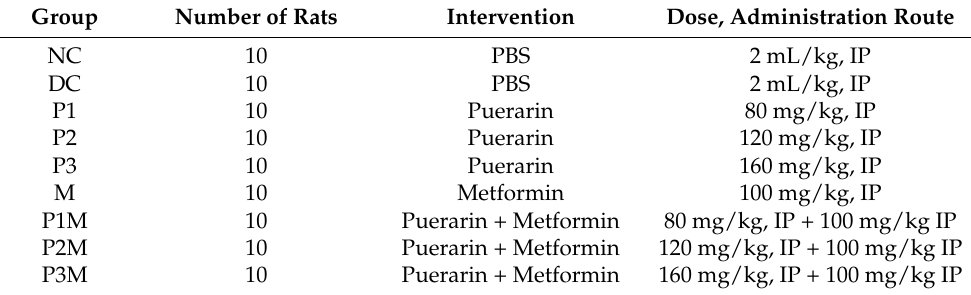
Table 1. Grouping of rats and intervention. Group Number of Rats Intervention Dose, Administration